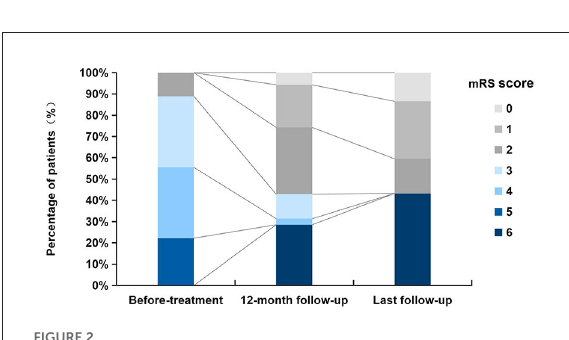
FIGURE2 Distribution of mRS scores before treatment, at 12-month follow-up, and at last